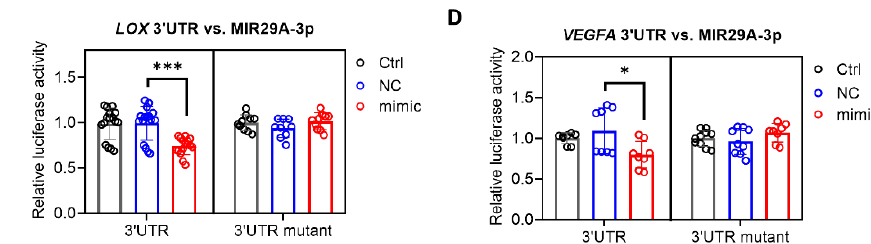
Figure 5. MIR29A -3p exerts a suppressive activity by directly targeting the 3 (cid:48) UTR of LOX and VEGFA . A schematic illustration of the pMIR-REPORTER TM plasmid for the cytomegalovirus (CMV)-driven luciferase reporter assay for MIR29A -3p on LOX ( A , C ) and VEGFA ( B , D ). Nucleotides in red denotes mismatched mutation as compared to that of wild type. After transfection of the pMIR-REPORTER TM plasmid, HepG2 cells were treated with transfection reagent transfection reagent as a control (Ctrl), miR negative control sequence (NC), or MIR29A -3p mimic (mimic), followed by the detection of luciferase activity. * p < 0.05, *** p < 0.001 between the indicated groups.